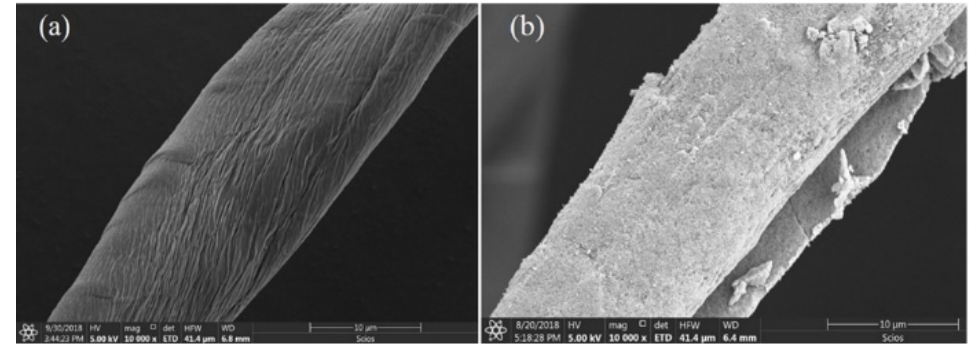
Figure 3. SEM images of ( a ) cotton fiber, ( b ) TiO 2 NPs-coated cotton fiber.